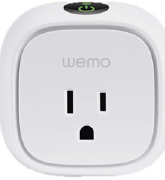
Figure 10. The Belkin WeMo InsightSwitch.